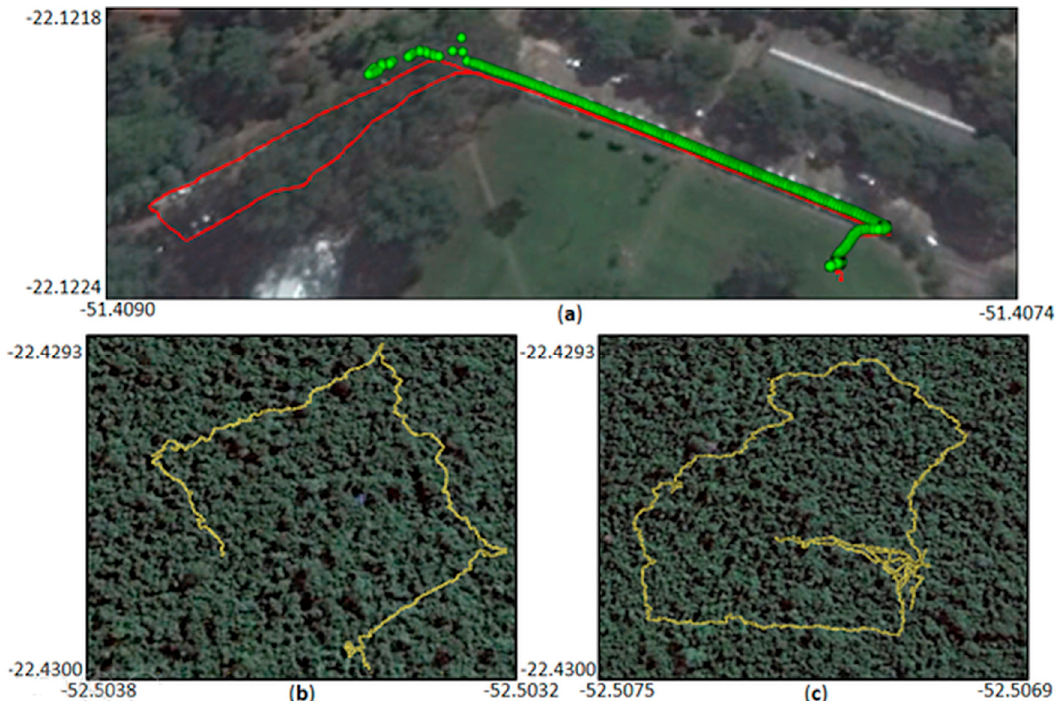
Figure 5. Ublox NEO-6M positioning accuracy: ( a ) Personal Mobile Terrestrial System trajectory in test area I with Ublox NEO-6M (red) and Topcon HiPer SR (green); and ( b , c ) examples of the trajectory with Ublox NEO-6M (yellow) inside test area II.